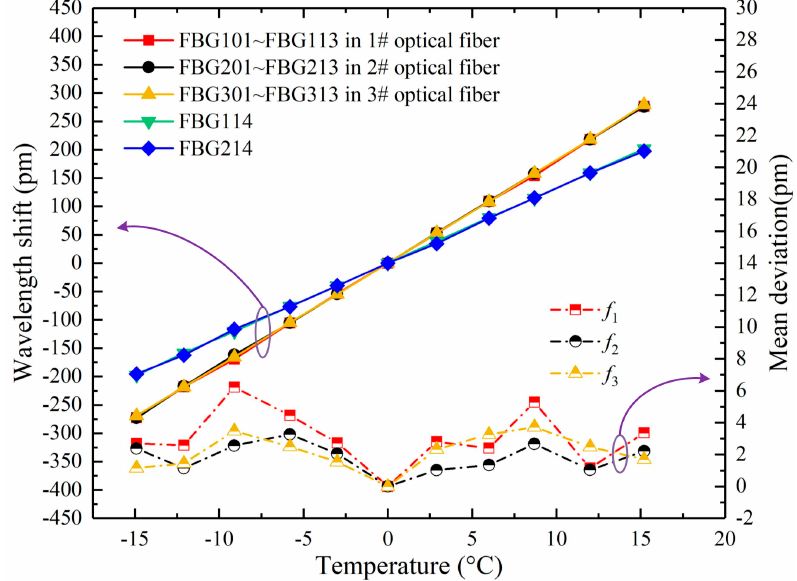
Figure 6. The relationship between wavelength shifts of FBGs and temperature.